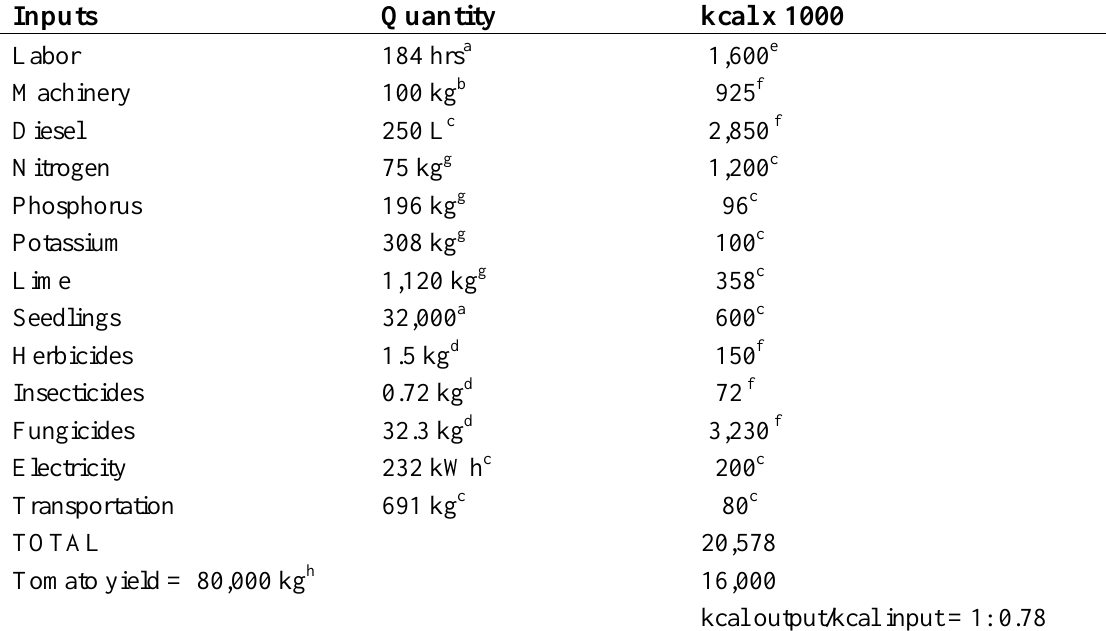
Table 13. Energy inputs of tomato production per hectare in the United